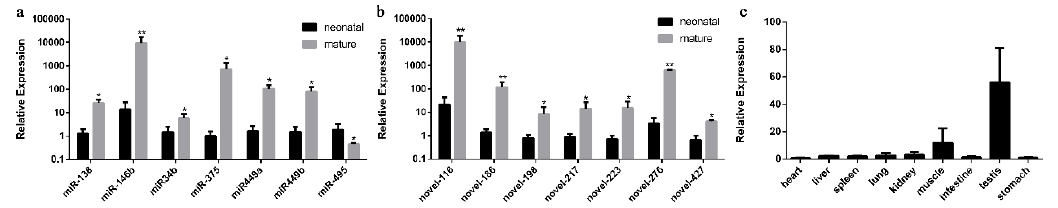
Figure 3. Validation of differentially expressed miRNAs by RT-qPCR. RT-qPCR validation of known ( a ) and novel ( b ) miRNA expression changes between neonatal and mature cattle testis. ( c ) The expression feature of bta-miR-146b in fetal tissues, including heart, liver, spleen, lung, kidney, muscle, intestine, testis and stomach. The data are present as the mean ± standard deviation of the mean; ** p < 0.01, * p < 0.05. The Y -axis represents the values that were calculated by log10.